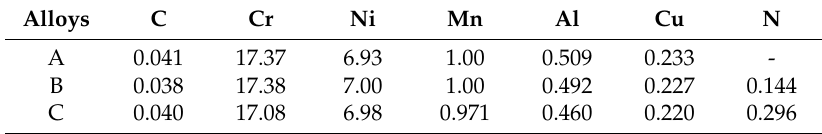
Table 1. Chemical composition of austenitic 301 stainless steels measured by ICP-OES.